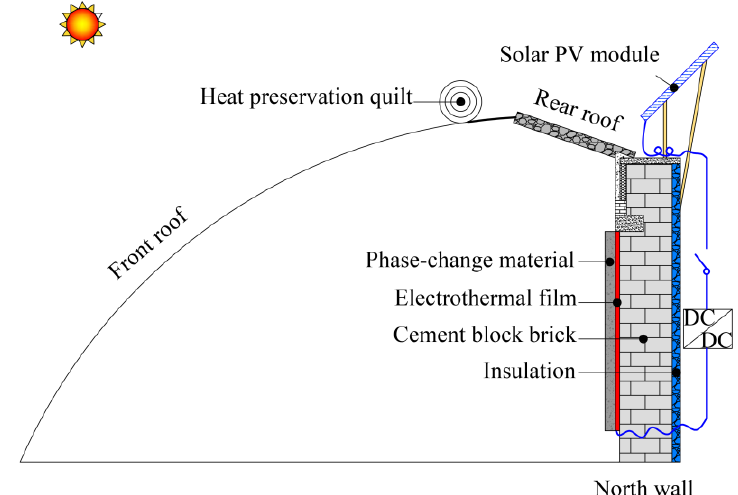
Figure 2. Calculation of power generation of monocrystalline silicon solar PV modules (Beijing, China).